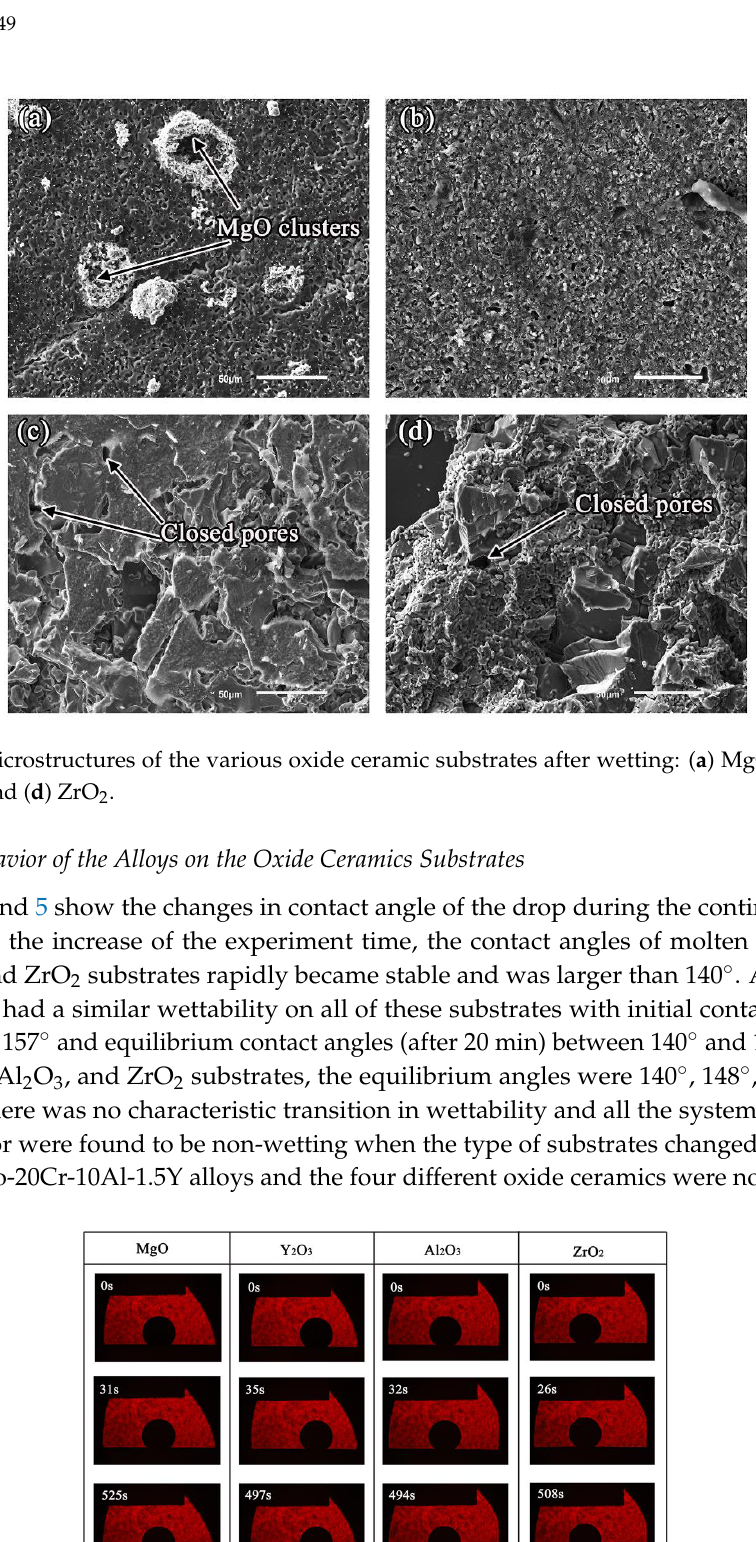
Figure 4. Wetting process of the Ni-20Co-20Cr-10Al-1.5Y alloys on various ceramic substrates substrates at 1873 K.